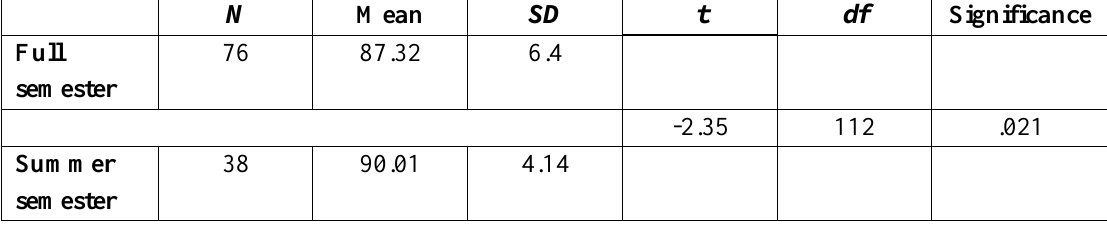
Student Performance N